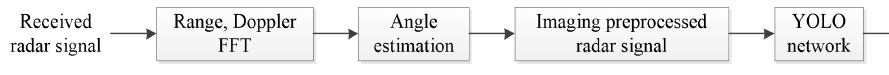
Figure 3. Diagram of proposed model.